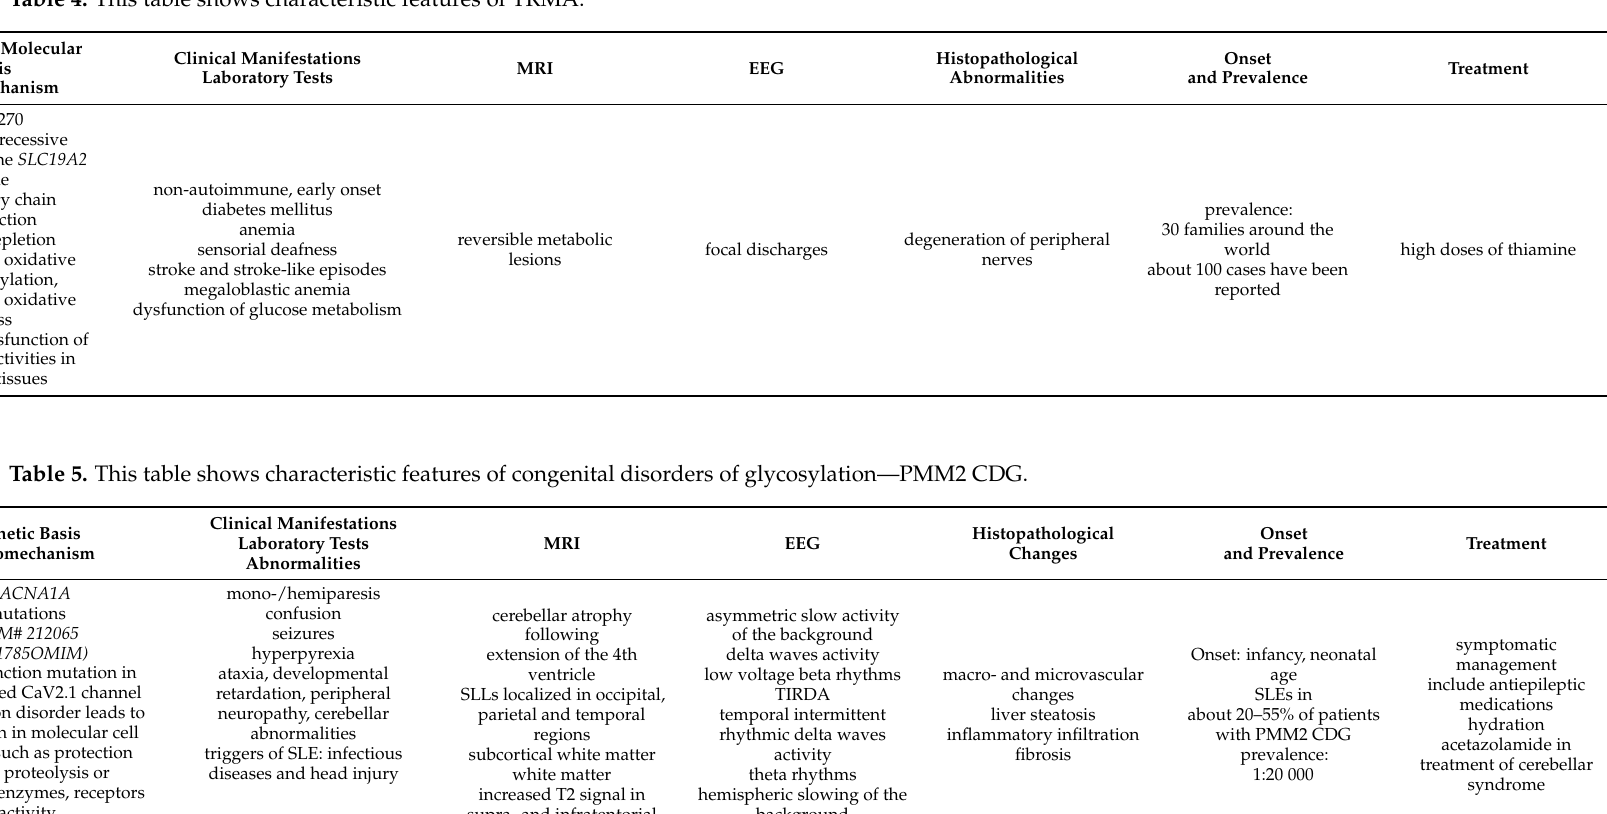
Table 4. This table shows characteristic features of TRMA.